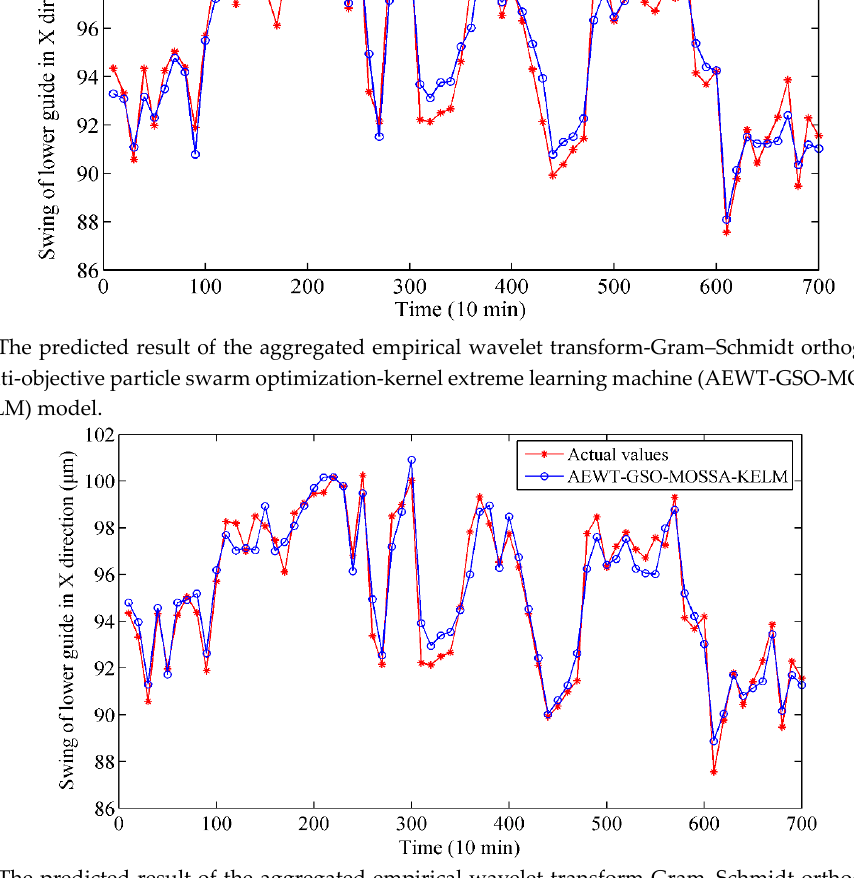
Figure 8. Comparisons of vibration data and prediction results with different methods: ( a ) EEMD ‐ KELM model, ( b ) EWT ‐ KELM model, ( c ) AEWT ‐ KELM model, ( d ) AEWT ‐ PCA ‐ KELM model, ( e ) AEWT ‐ GSO ‐ SVR model, ( f ) AEWT ‐ GSO ‐ SSA ‐ KELM model, ( g ) AEWT ‐ GSO ‐ MOPSO ‐ KELM model, and ( h ) AEWT ‐ GSO ‐ MOSSA ‐ KELM model.